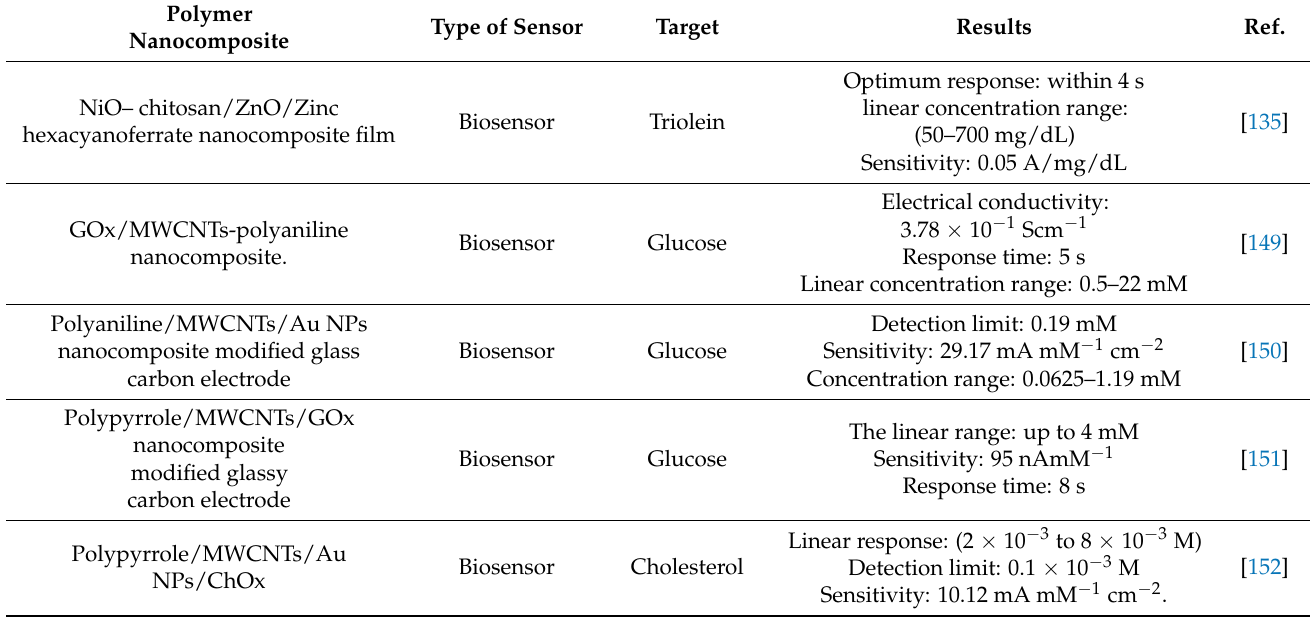
Table 3. Performance of some polymer nanocomposites in